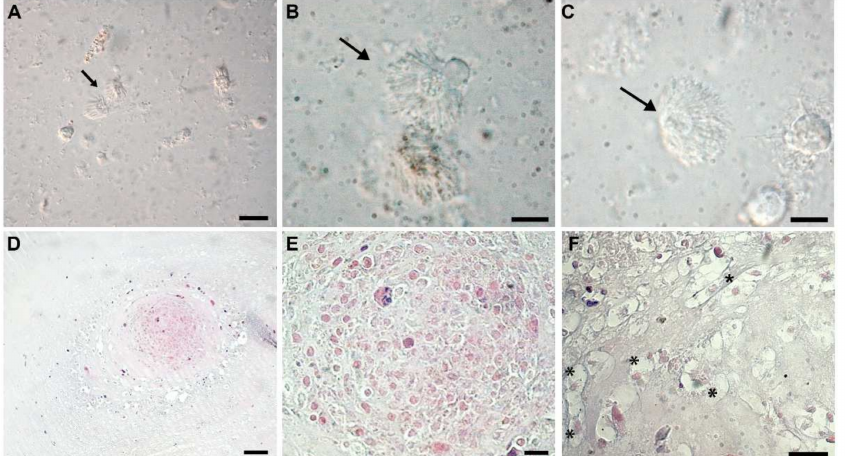
Figure 3. Morphological analyses. ( A – C ) Cyst cell culture in which peculiar ciliated cells are observ- able (arrow). These protist-like cells displayed heterogeneous cytoplast and their cell membrane was covered by numerous motile cilium-like structures ( B , C ). ( D – F ) Histological analysis revealed that the cyst masses consisted of a thin capsule of connective tissue encircling a central area of mucus material in which numerous granulocytes, plasma cells, and lymphocytes were detected ( D , E ). Among these, ciliated protist-like cells were present trapped in the mucus ( F ); asterisks identify trapped cells. Scale